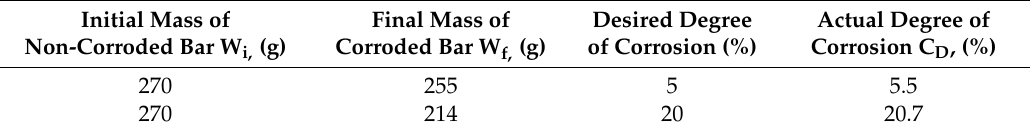
Table 2. Desired and actual degree of corrosion of corroded steel bars.